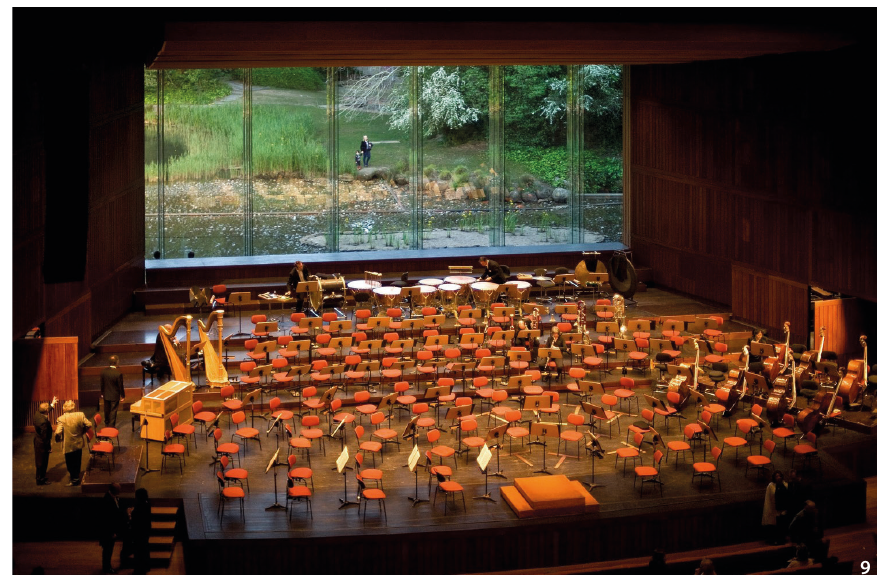
Figure 9 Alberto Pessoa, Pedro Cid, Rui Athouguia, Calouste Gulbenkian Foun- dation, Lisbon, Portugal, 1969. Audi- torium after the renovation (Source: Márcia